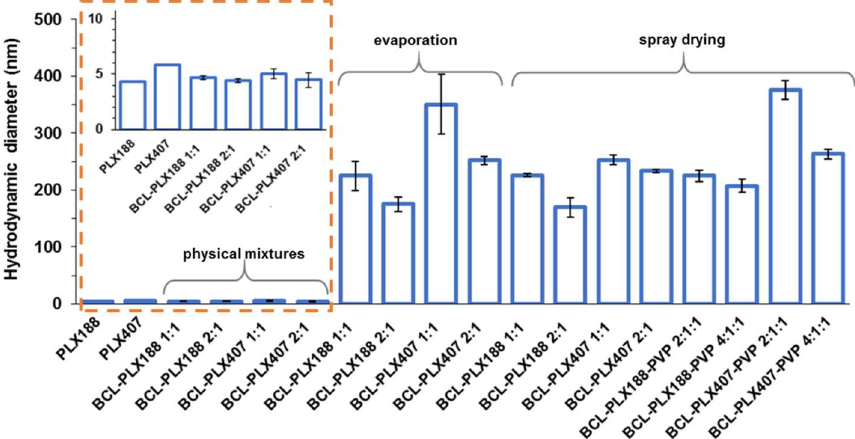
Figure 10. Hydrodynamic diameters of aggregates formed in aqueous solutions of poloxamers, physical mixtures, and binary systems obtained using either the evaporation method or spray drying. Insert: zoomed data corresponding to raw PLXs and physical mixtures.